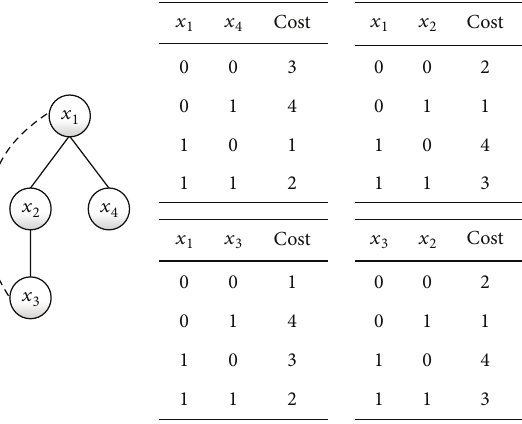
Figure 4: Constraints and pseudotree generated by